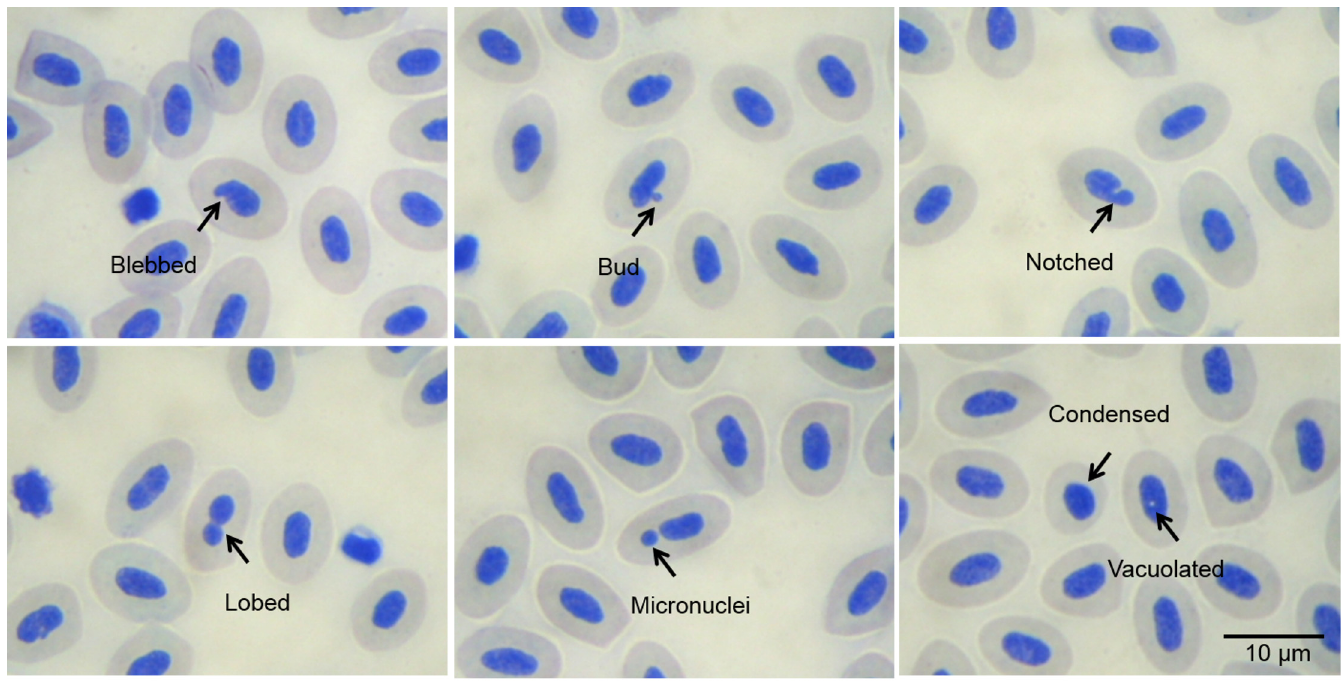
Fig 5. Alterations in erythrocytes of O . niloticus stained by May-Grunwald in in vivo assay.